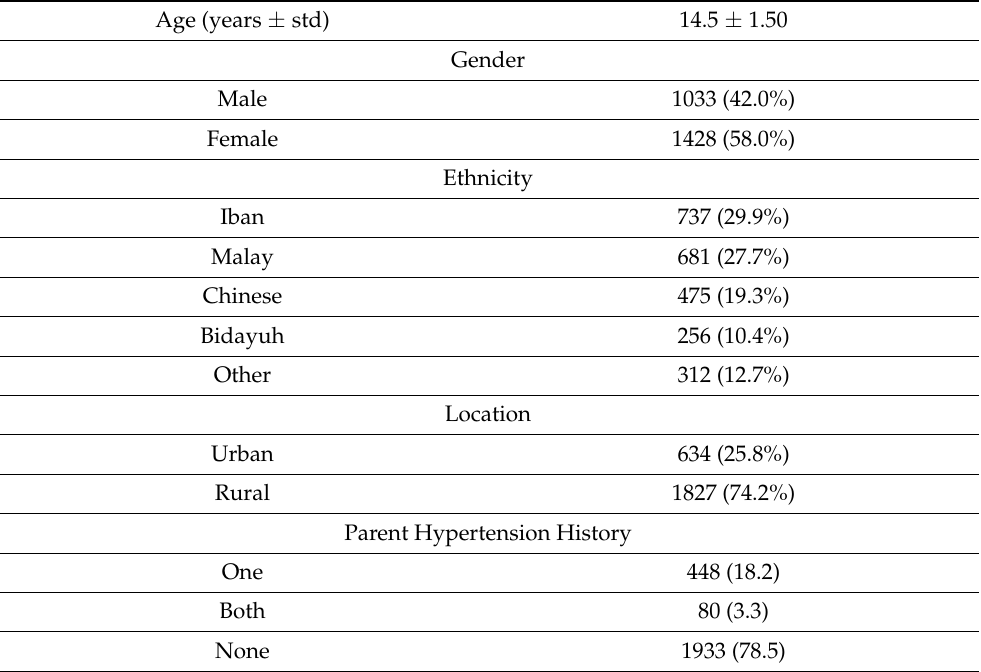
Table 1. Demographic data